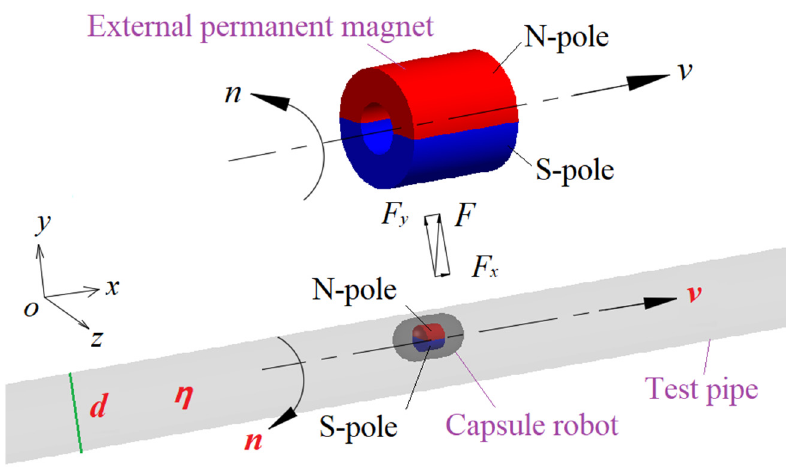
Figure 1. Structure and related parameters of the capsule robot.